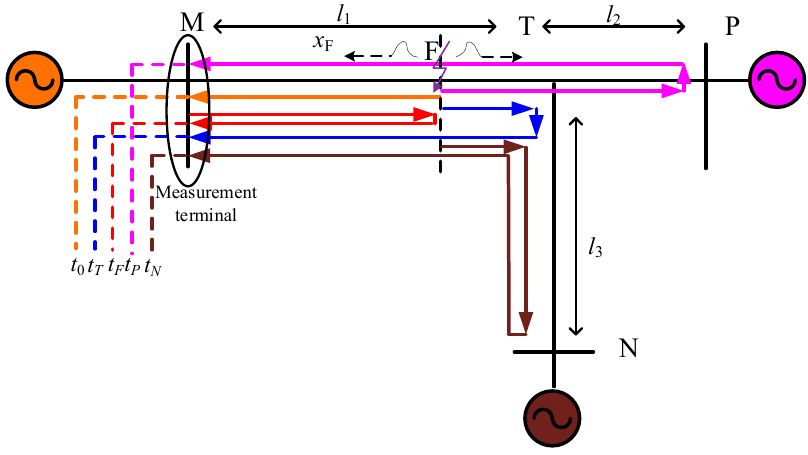
Figure 3. Travelling wave propagation path within l 1 − x F < x F < l 1 + l 2 − x F . The time of travelling waves arriving the terminal M and the propagation paths are listed in Table